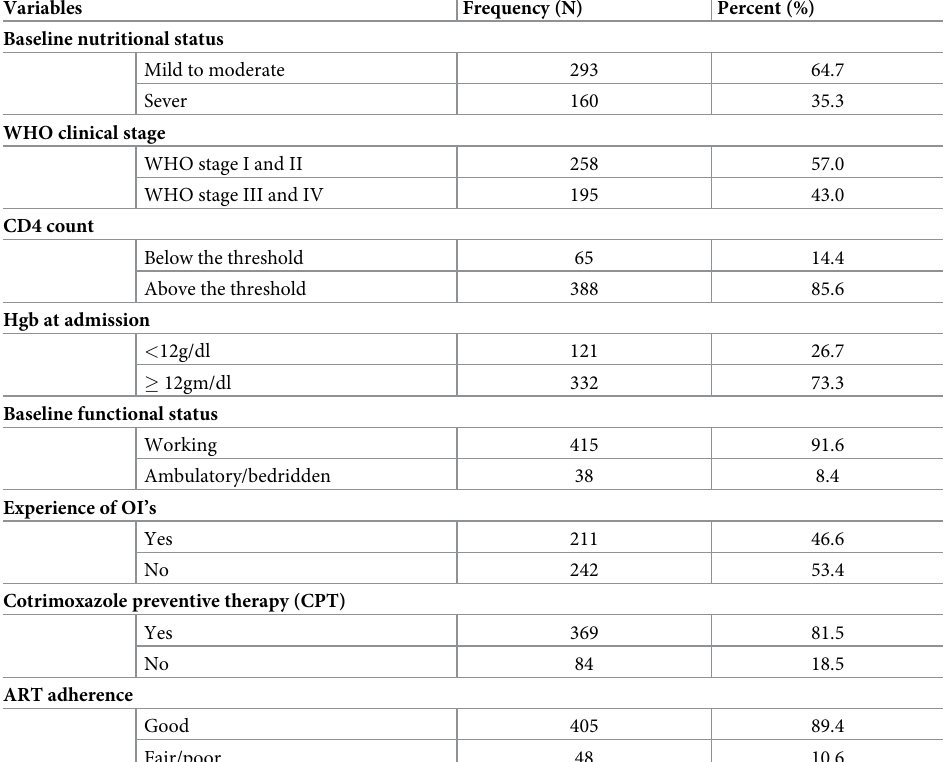
Table 3. Clinical, nutritional and HIV/AIDS related characteristics patients at Debre Markos Referral Hospital from July of 1 st , 2015 to December of 31 st , 2017.